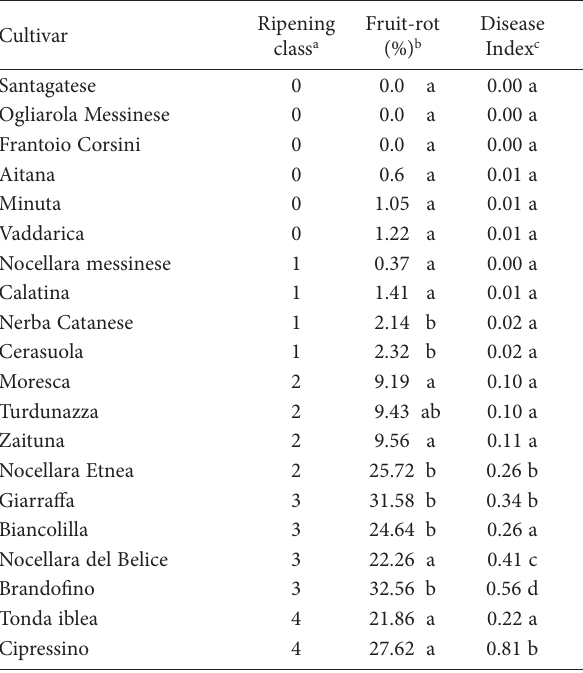
Table 3. Olive fruit ripening classes and disease reactions (mean fruit rot incidence and mean disease index) for 20 selected olive cultivars, naturally infected by Colletotrichum spp., in the Interna- tional Olive Germplasm Collection (IOGC), Villa Zagaria, Enna,